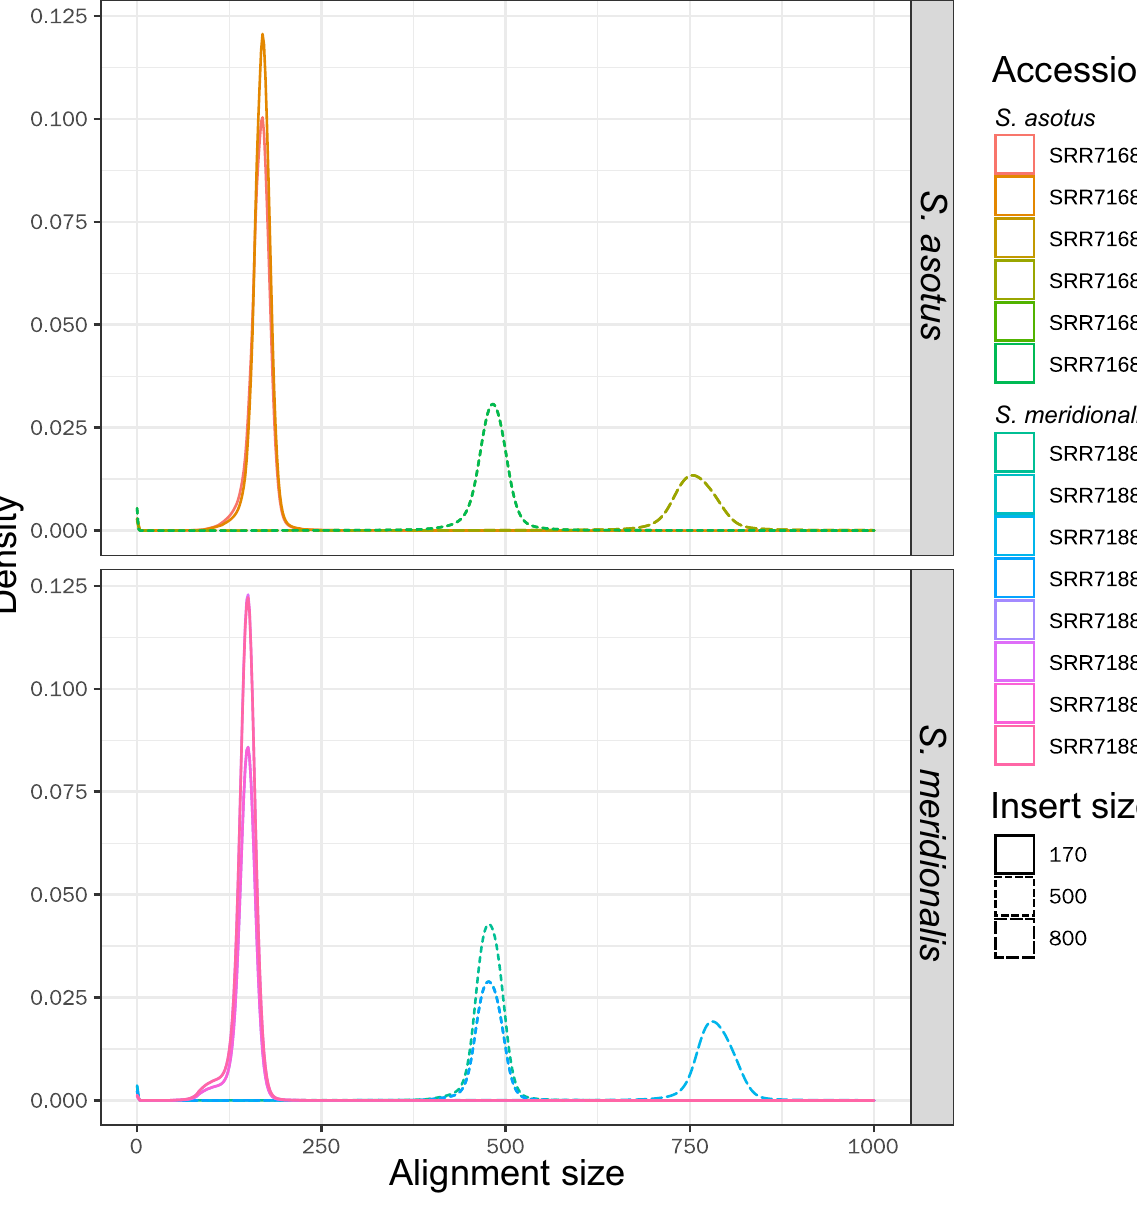
Figure 3. The insert length distribution estimated using the genome sequences divided from the hybrid genome as reference for each of the libraries constructed for the non-hybrid parental species S. asotus and S. meridionalis